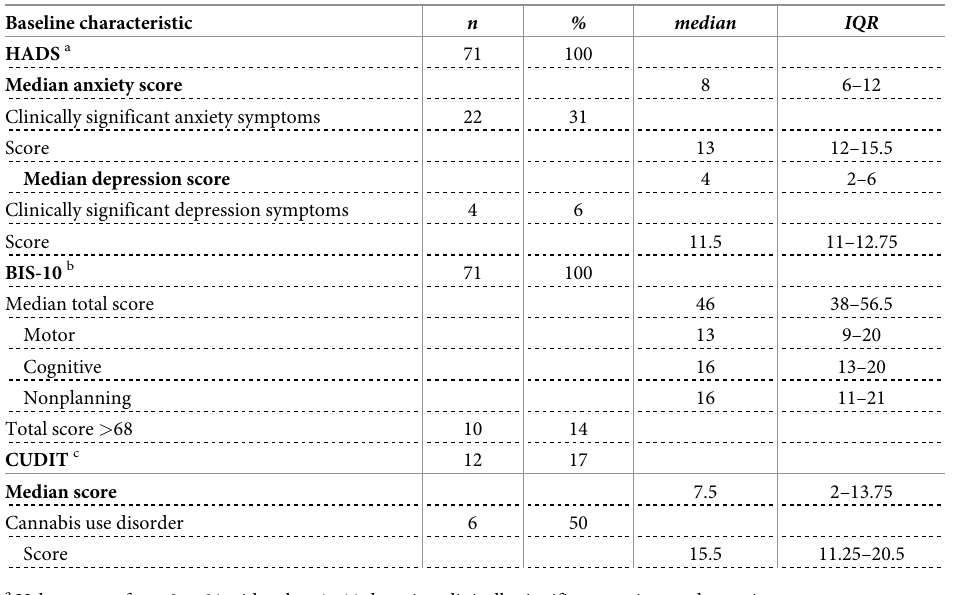
Table 3. Scores on HADS, BIS-10 and CUDIT scales in the study population. Baseline characteristic